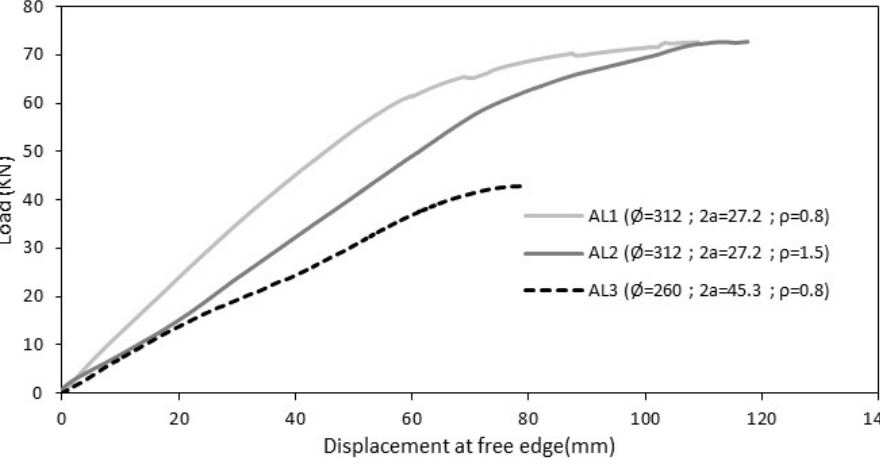
ff erent tubular